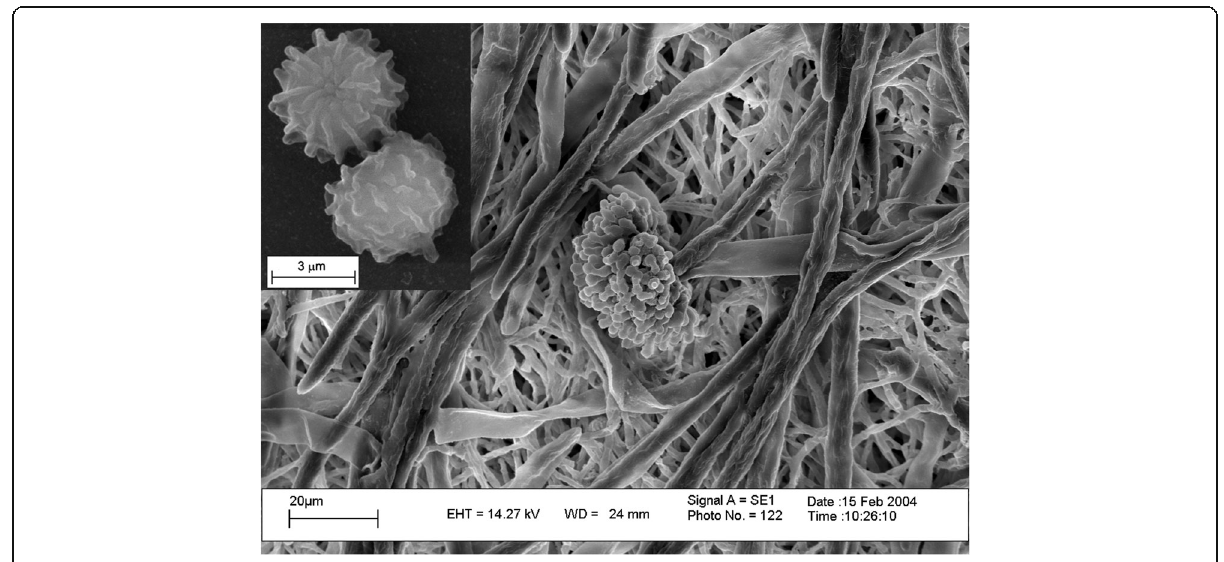
Fig. 1 Electron micrograph of Aspergillus niger strain ATCC 10864. Inset: ornamented